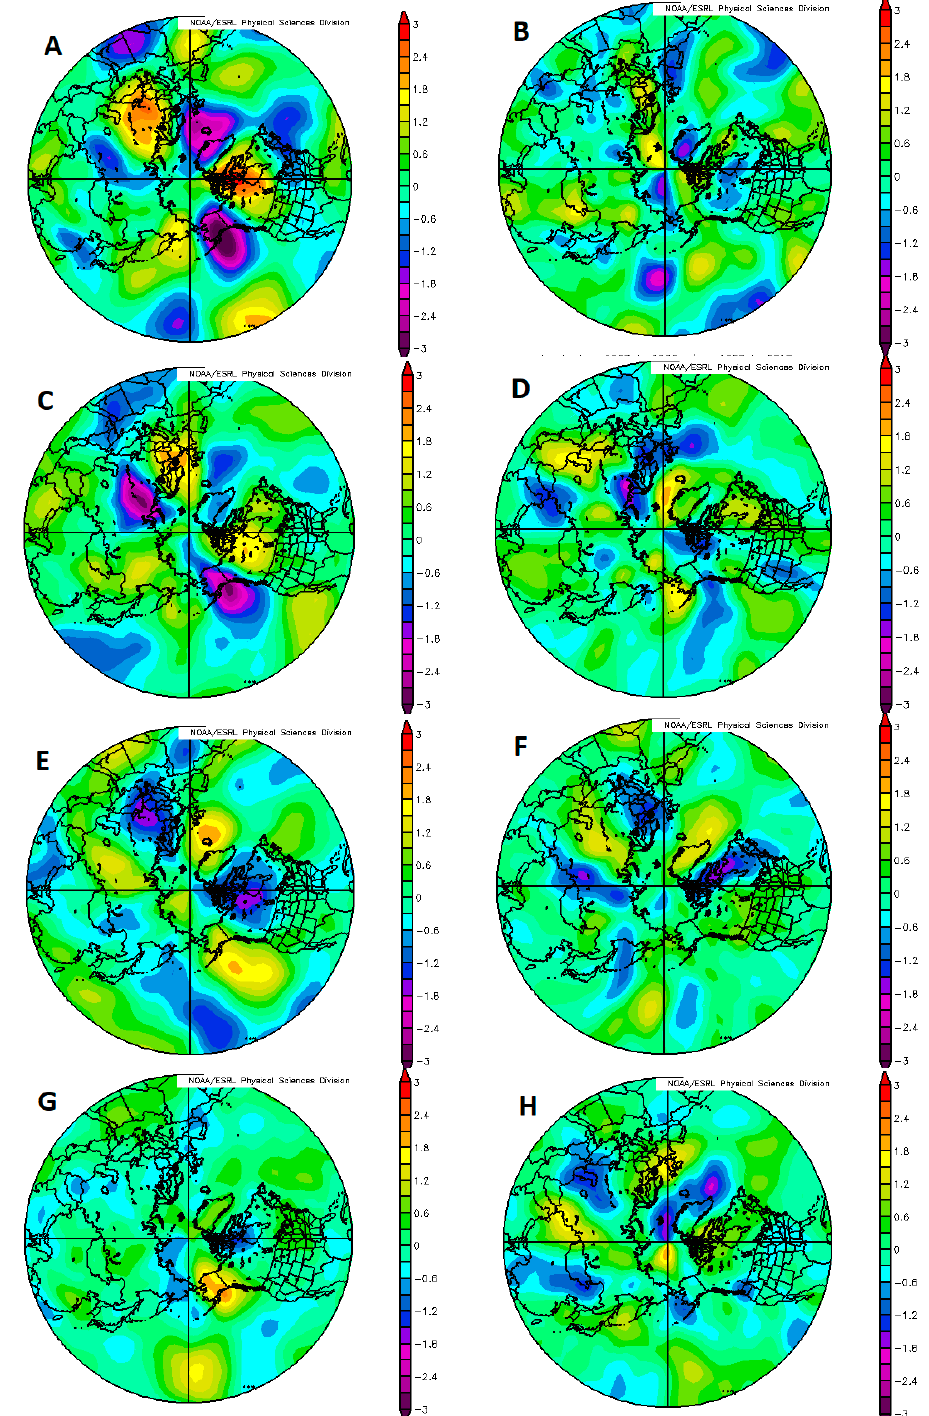
Figure 4. As in Figure 3, except for the 300 hPa meridional wind anomalies (m s − 1 ), and the contour interval is 0.3 (m s − 1